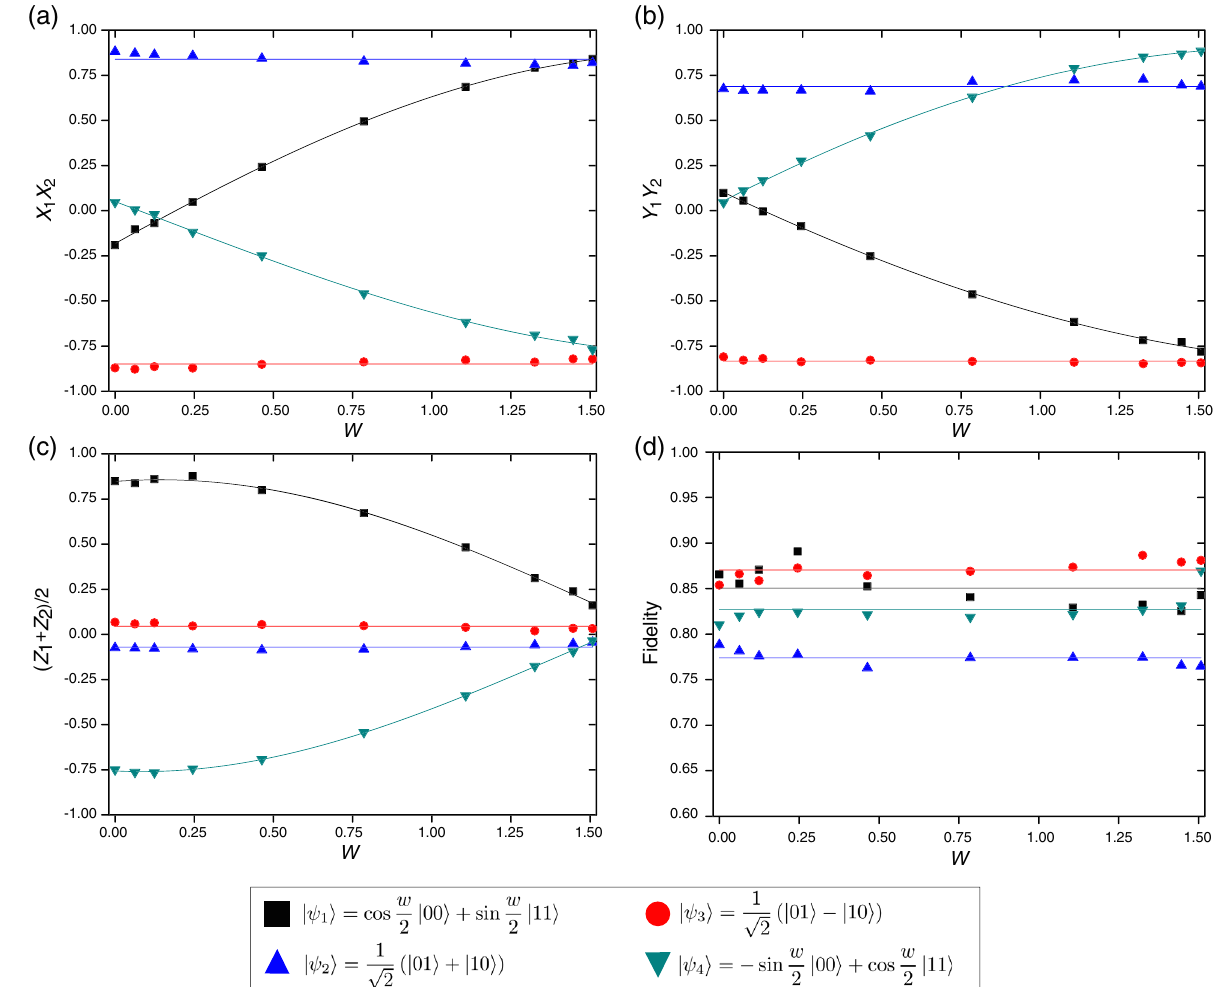
FIG. 3. Characterization of the eigenstates of the XY Hamiltonian. We show the measurement of the three components of the two-qubit XY Hamiltonian separately. (a) Correlations when measuring the qubits in the basis σ ⊗ σ x x . (b) Correlations when measuring the qubits in the basis σ y ⊗ σ y . (c) Correlations when measuring the qubits in the basis ð σ z ⊗ 1 þ 1 ⊗ σ z Þ = 2 . This separate measurement of each part of the Hamiltonian makes it possible to see the measured data for each part separately and thus enables a more detailed analysis of each part of the Hamiltonian. The panels (a) – (c) show that an uncertainty in w would lead to only a small change in the measured correlation. (d) Fidelities of the generated states. In all panels, the lines show a fit of the experimental data. The error bars are smaller than the point size and hence not